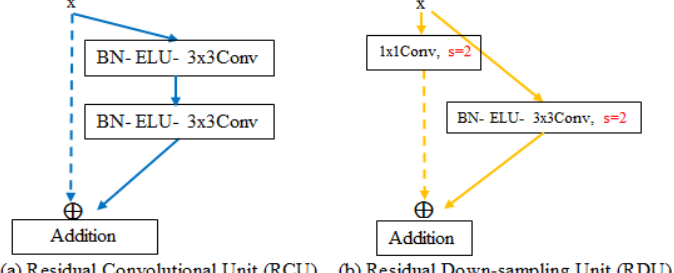
Figure 8. The encoder mainly consists of RCU with BN and RDU proposed by